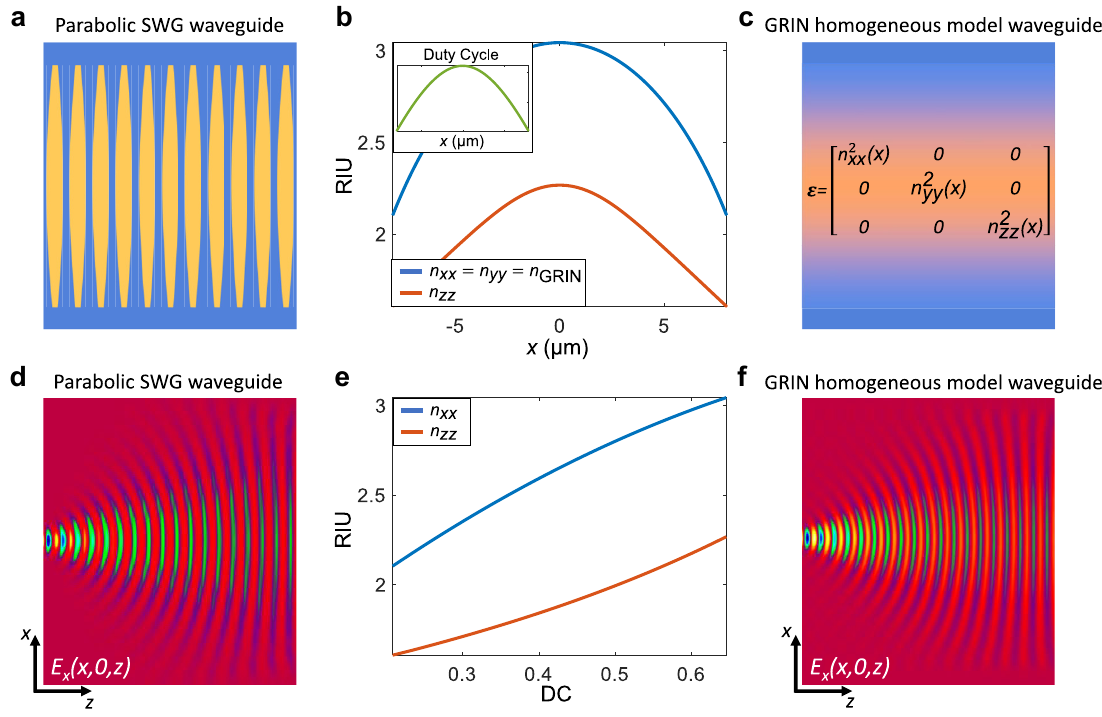
Figure 22: (a) Schematic representation of the SWG GRIN lens proposed in Ref. [32]. (b) Desired gradual index pro fi le ( n GRIN ) and the corresponding n zz implemented with the proposed structure. Inset: Duty cycle apodization function DC( x ) which implements the desired pro fi le.(c)SchematicrepresentationoftheGRINmetamaterialwhichmodelstheproposedstructure.(d,f)Full-vectorial3D-FDTDsimulationof the electric fi eld (R{ E x ( x ,0, z )}) propagating through a GRIN lens implemented with (d) a periodic SWG structure and (f) a gradual anisotropic ( x ) , n 2 ( x ) , n 2 ( x )] ,withtheindicesshownin(b).(e)Metamaterialtensorcomponents n metamaterial ε ( x ) = diag [ n 2 xx yy zz duty cycle DC = a / x .